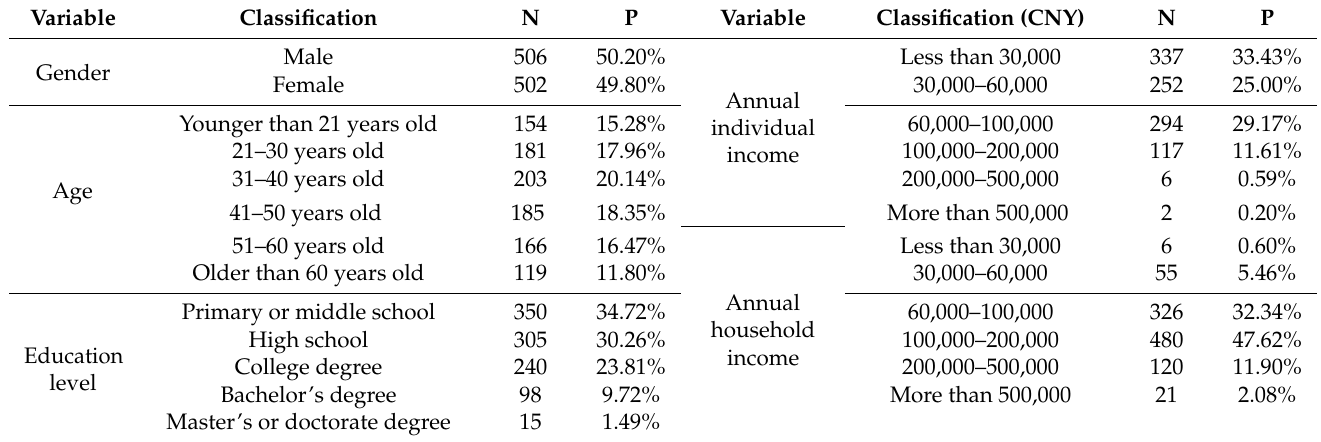
Table 1. Demographic distribution of 1008 respondents in Shaanxi province.